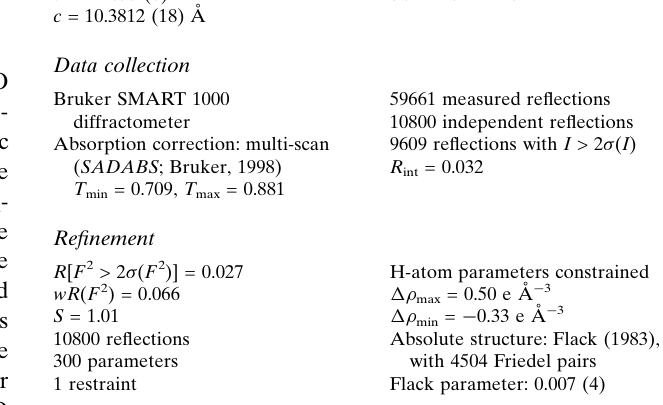
Data collection Bruker SMART 1000 diffractometer Absorption correction: multi-scan ( SADABS ; Bruker, 1998)